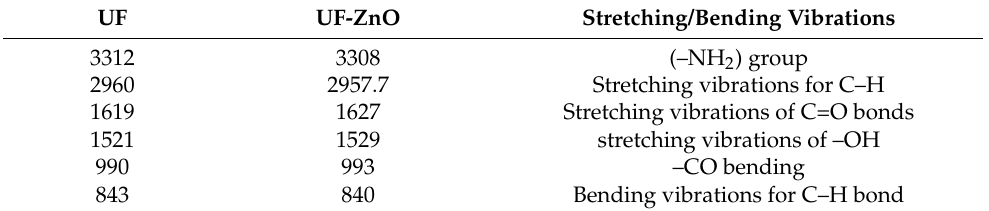
Summary of Fourier-transform infrared (FT-IR) spectroscopy of ZnO and UF- ZnO